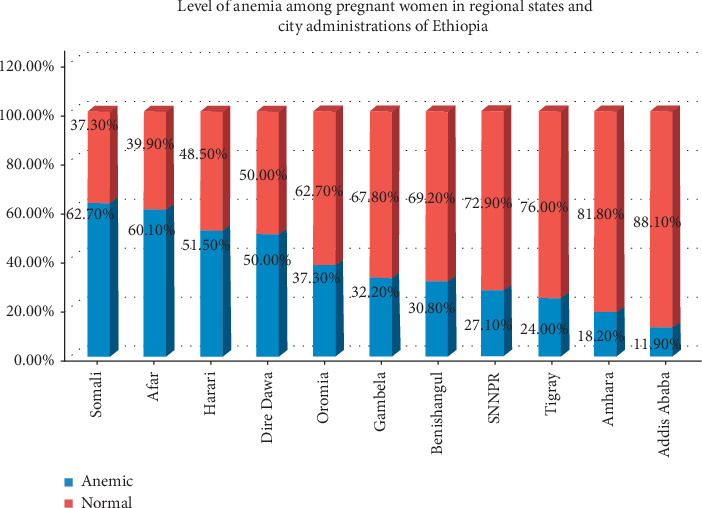
Regional distribution of anemia among pregnant mothers (n = 3082).